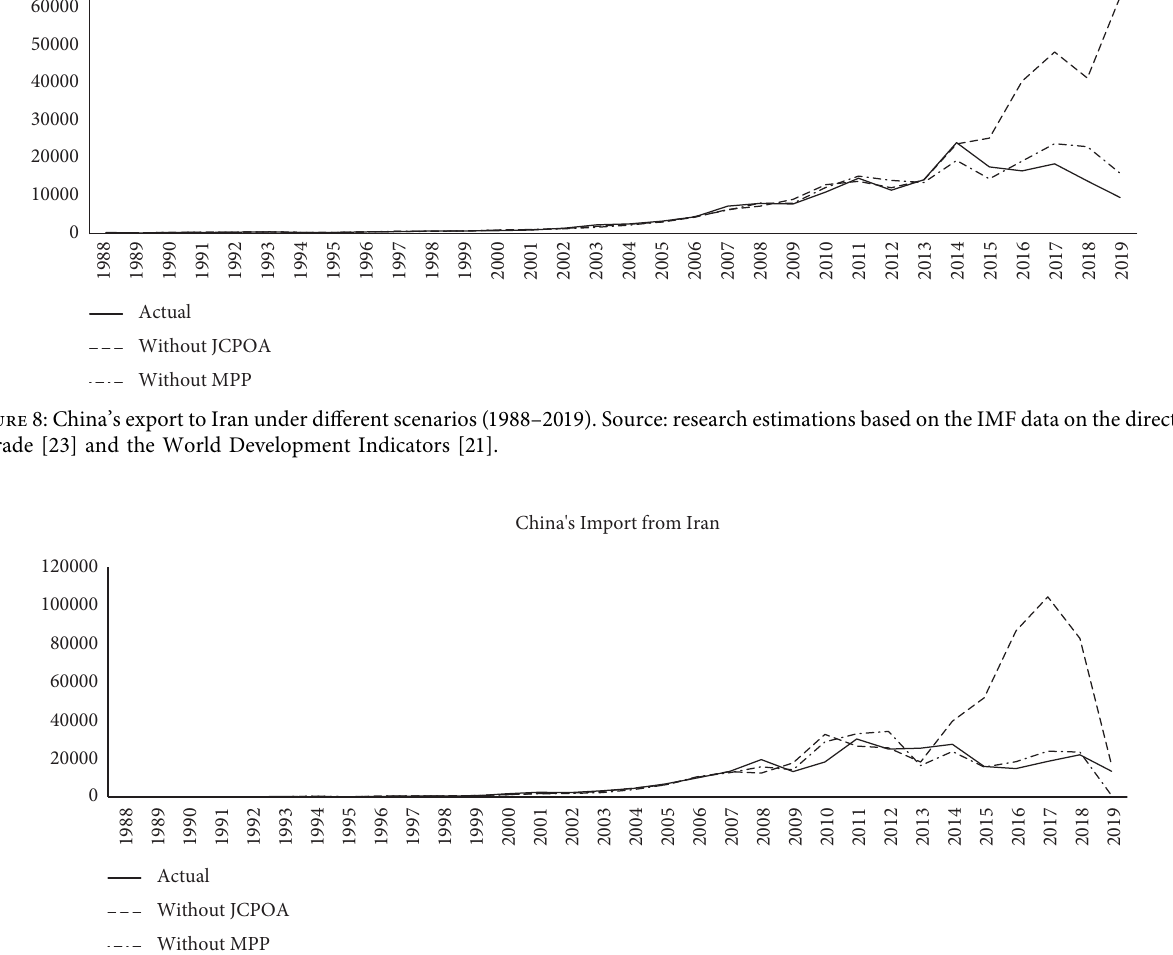
Figure 9: China’s imports from Iran under diferent scenarios (1988–2019). Source: research estimations based on the IMF data on the direction of trade [23] and the World Development Indicators